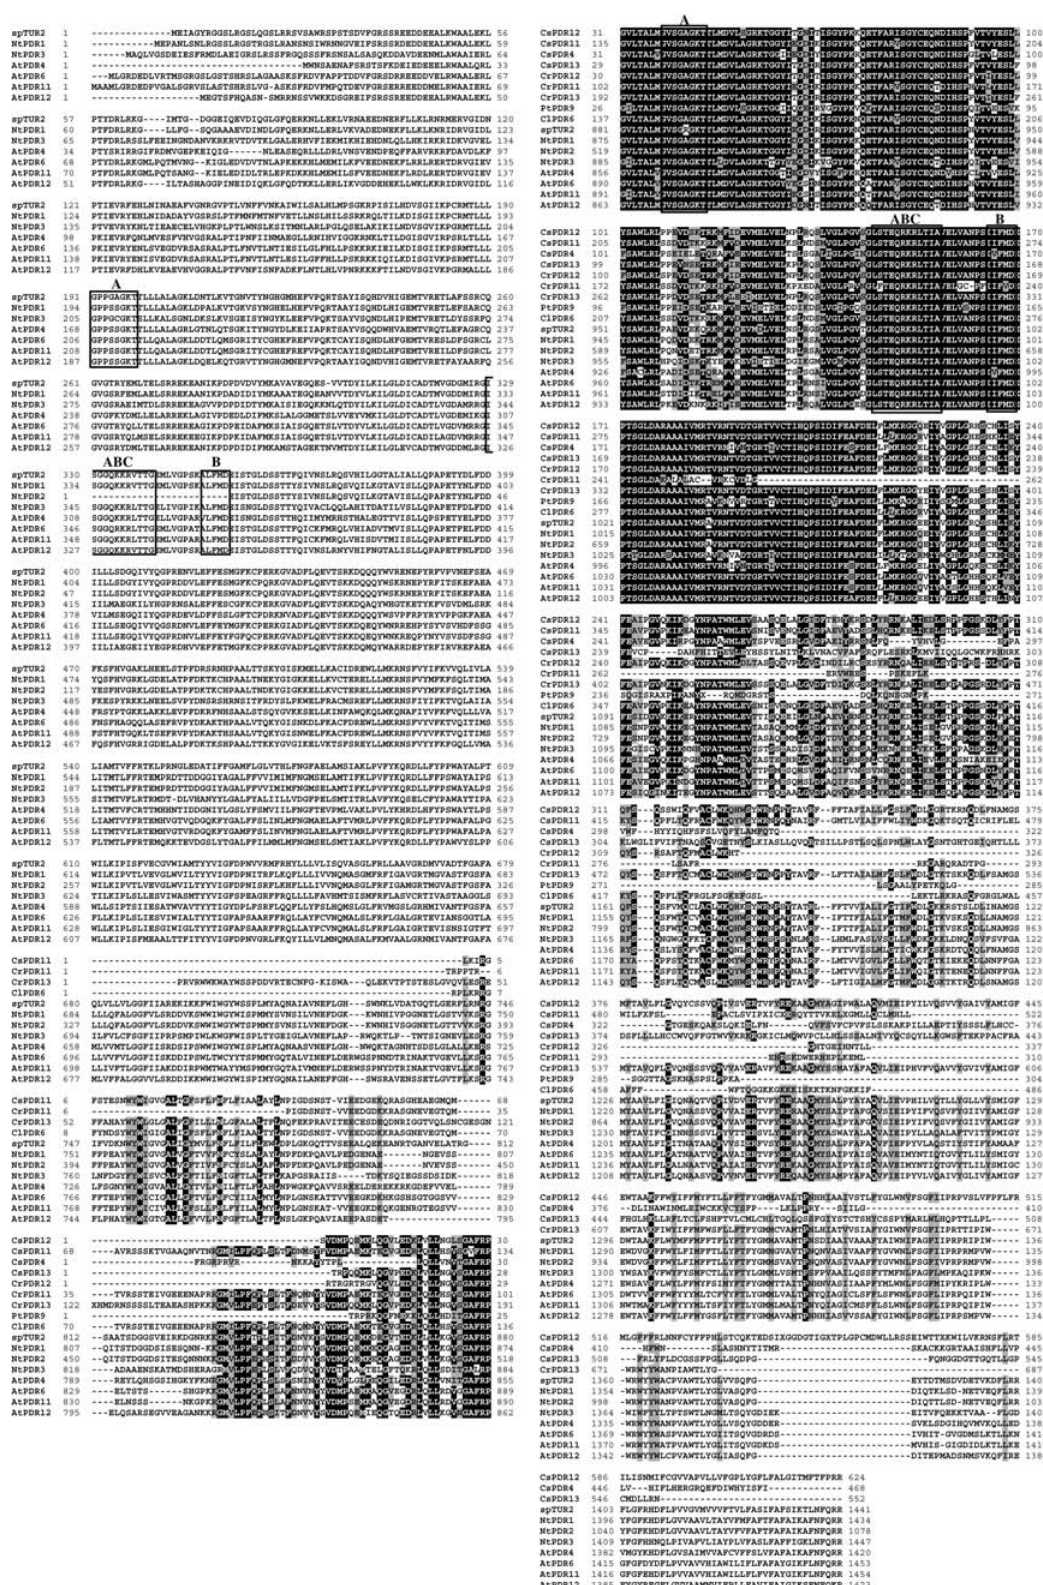
Figure1 -MultiplealignmentoftheconserveddomaininPDRproteinsofCitESTcontainingABCsignatureandWalkerAandBmotifs,alignedtoplant PDRs SpTUR2 (accession no. O24367), NtPDR1 (Q76CU2), NtPDR2 (BAD07484), NtPDR3 (Q5W274), AtPDR4 (DAA00872), AtPDR6 (AAD24623), AtPDR11 (DAA00879), and AtPDR12 (NP_173005), using the CLUSTAL W program (Higgins et al. ,